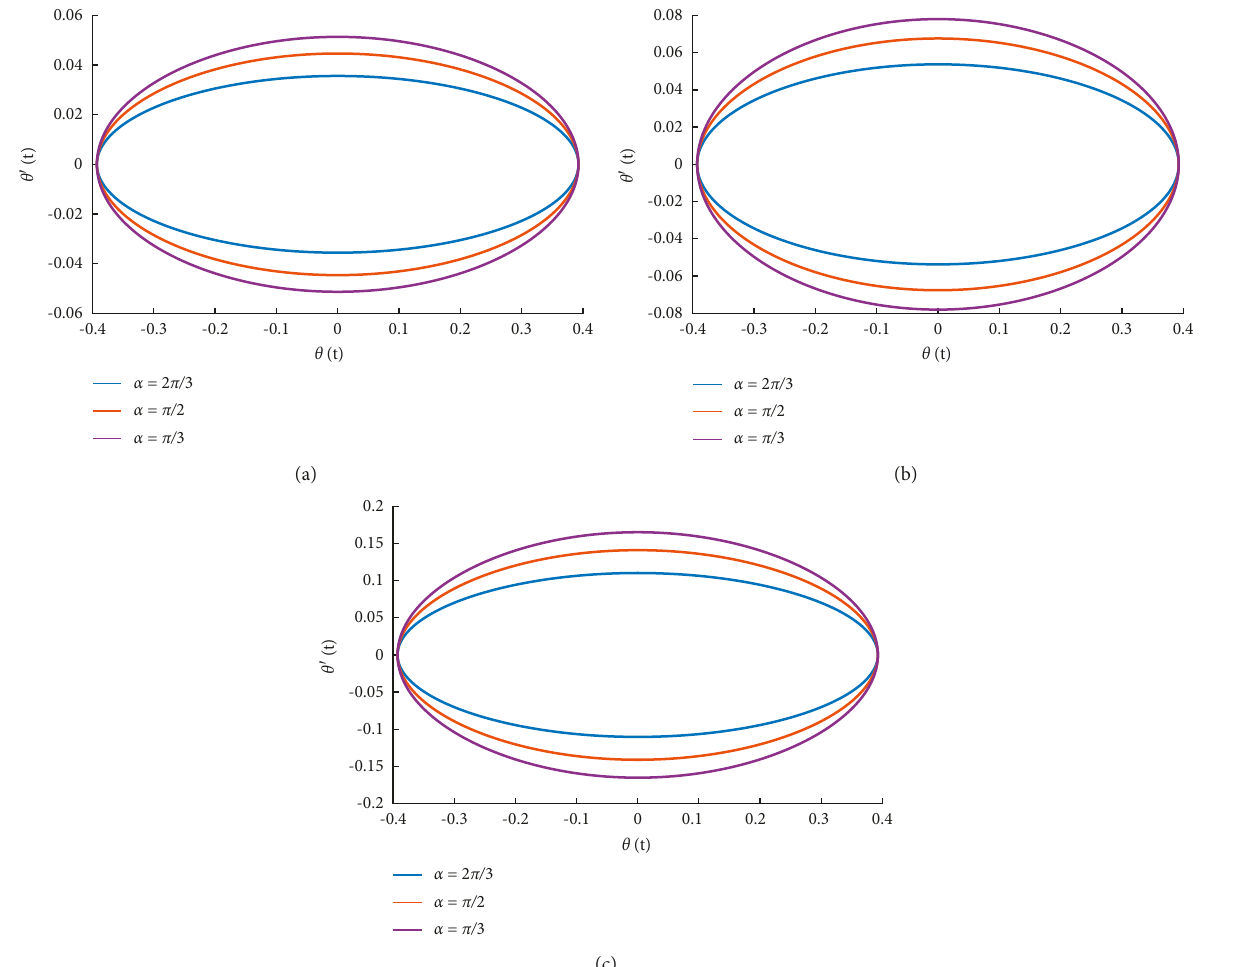
Figure 5: Stability analysis in terms of angular velocity and acceleration by CNN-BLM algorithm for different cases of scenarios 1, 2, and